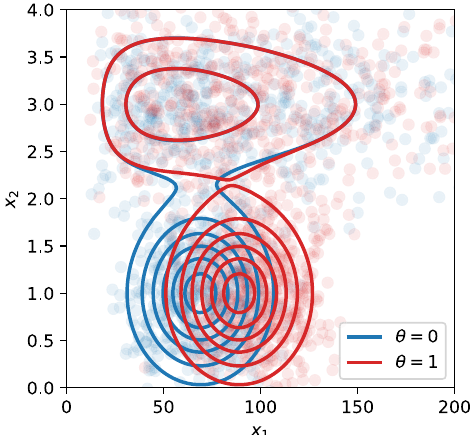
Fig. 8 Examples of PDFs (solid lines) and generated sample points (translucent circles) for different values of θ for the model of Sect. 5.3 x 1 value is not related to the unknown parameter. This com-